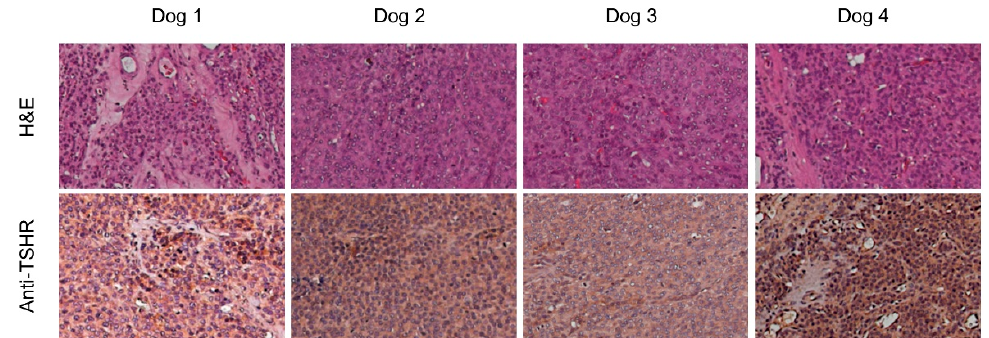
Figure 2. Histological section of excised lesion from the 4 dogs stained with hematoxylin/eosin (top panels), revealing a solid/trabecular follicular thyroid carcinoma (200× magnification). Histological section stained with an anti-dog-TSHR antibody reveals homogeneous staining in almost all cancer cells (bottom panels).